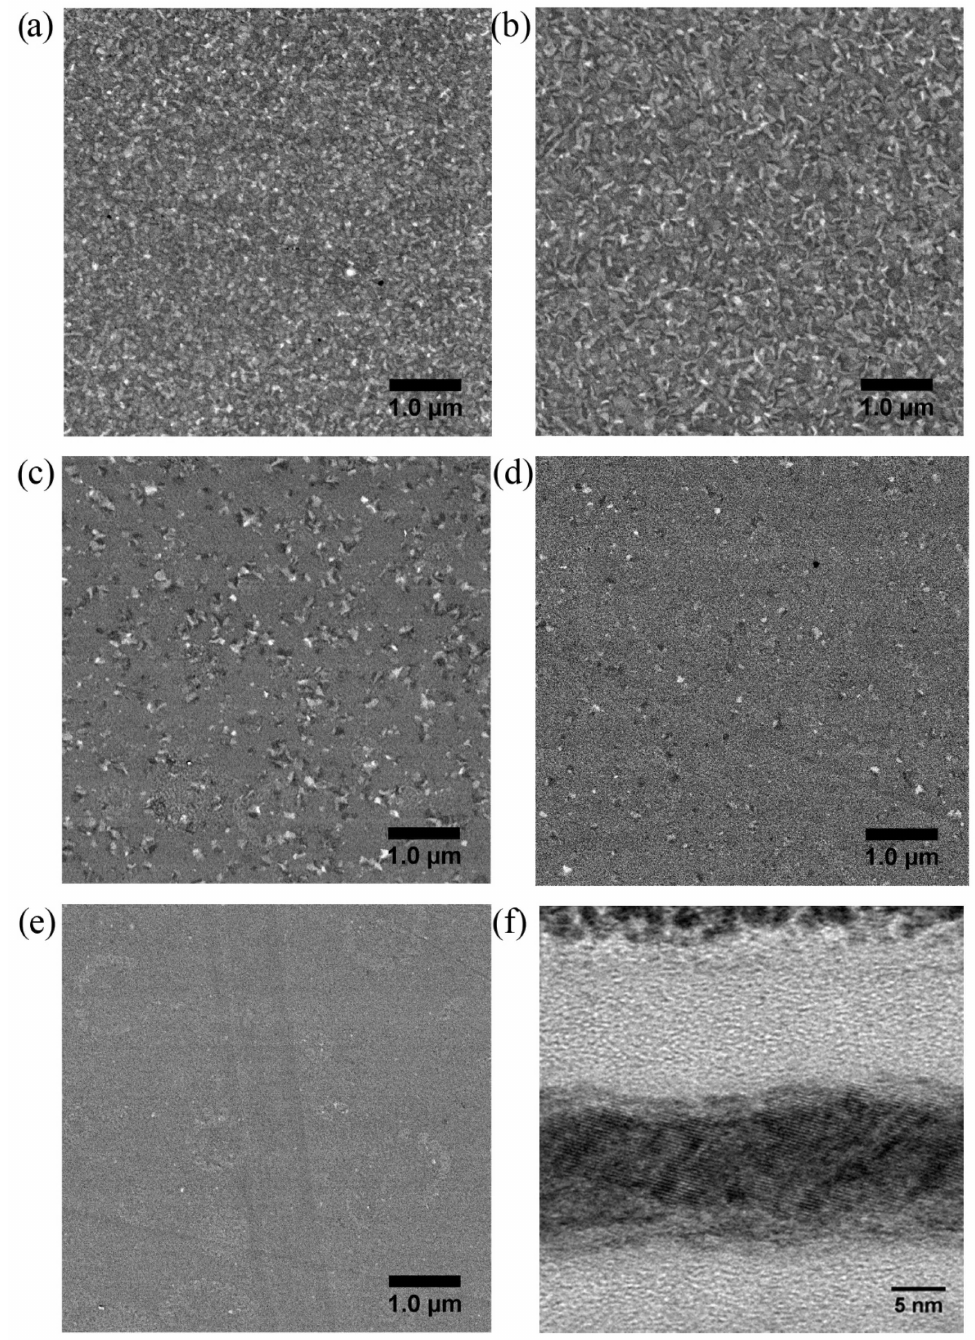
Figure 3. ( a ) Scanning electron microscopy images of the TF1 film recorded at ( a ) the center of the crystallized zone, ( b ) 2.3 mm from the center, ( c ) 5.1 mm from the center, ( d ) 5.2 mm from the center, ( e ) outside the annealed zone. The radius of the crystallized zone is 5.5 mm. ( f ) HRTEM image of a cross-section of sample TF3 prepared by